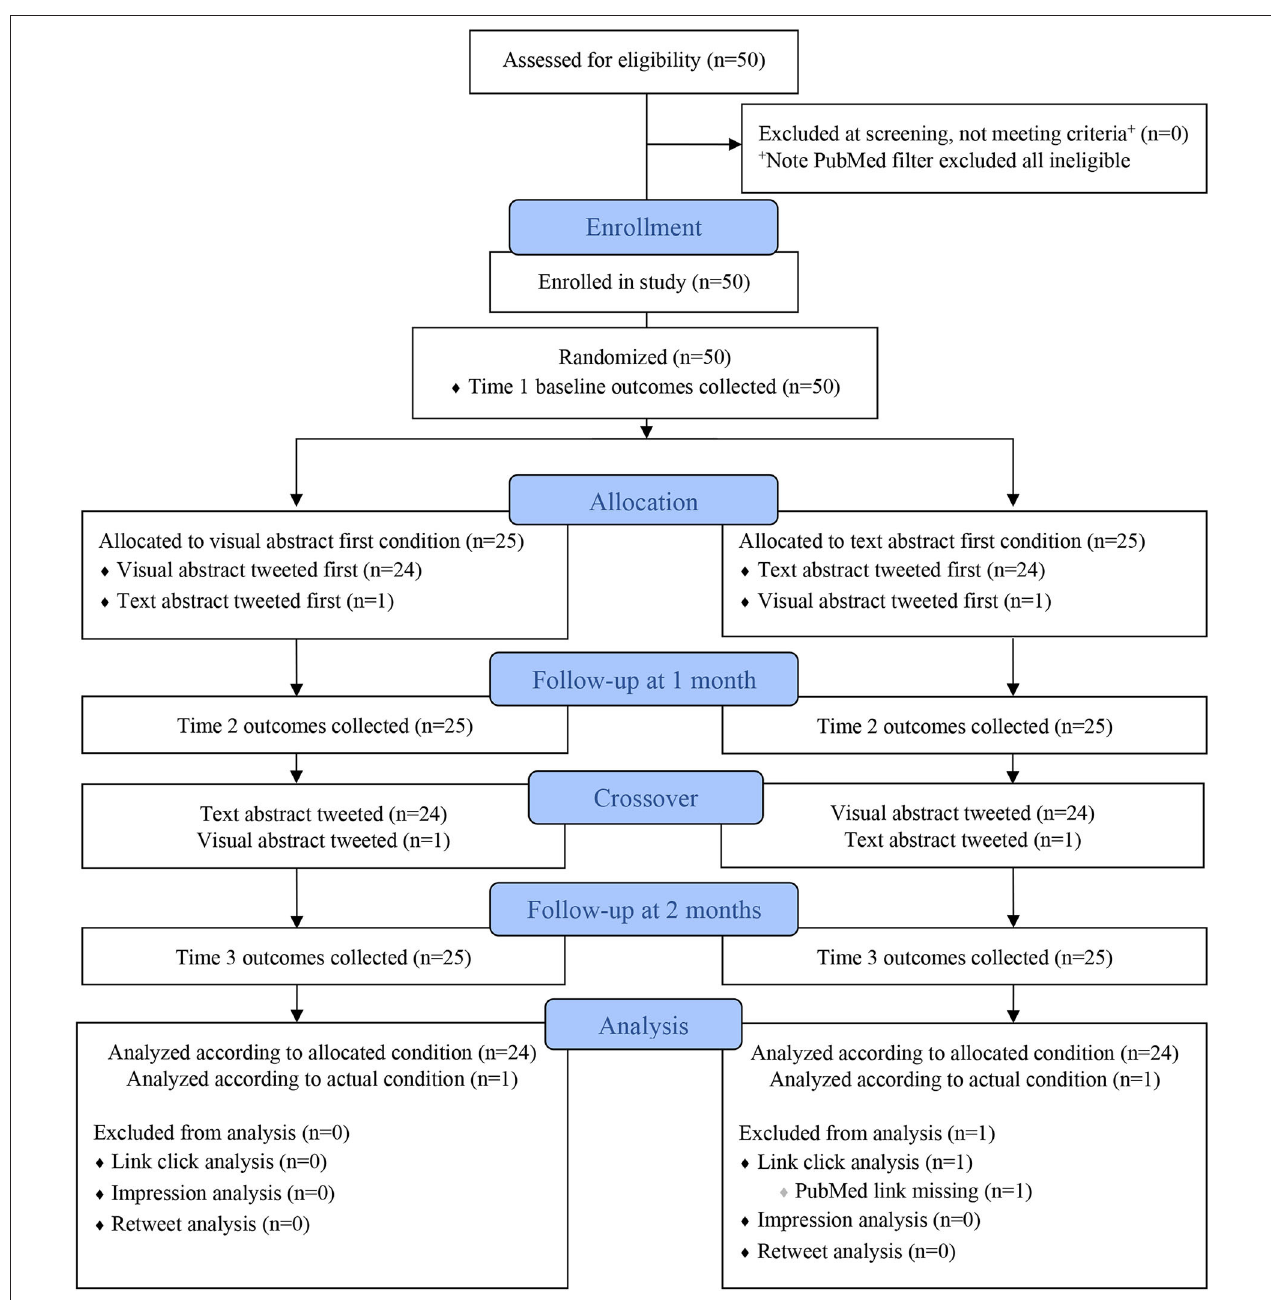
FIGURE 1 | Consolidated Standards of Reporting Trials (CONSORT) Extension to Crossover Trials Flow